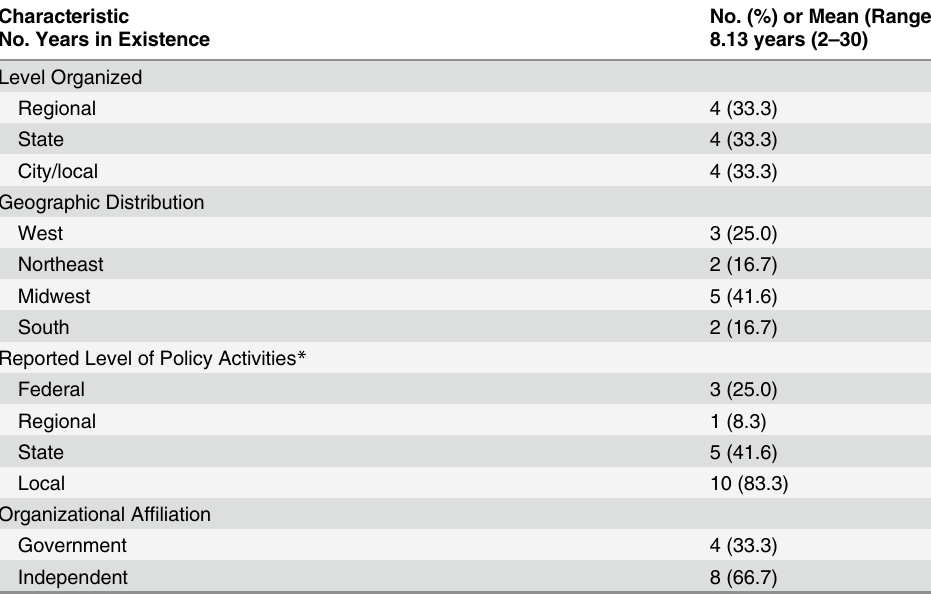
Table 2. Characteristics of FPCs Interviewed **